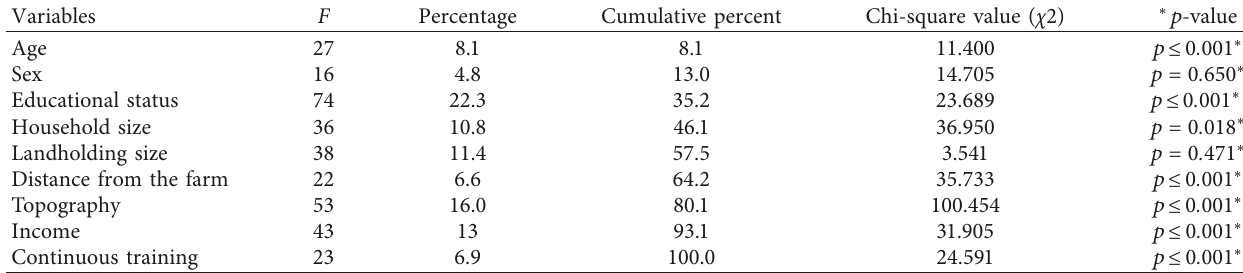
Table 9: Factors that determine techniques for soil and water